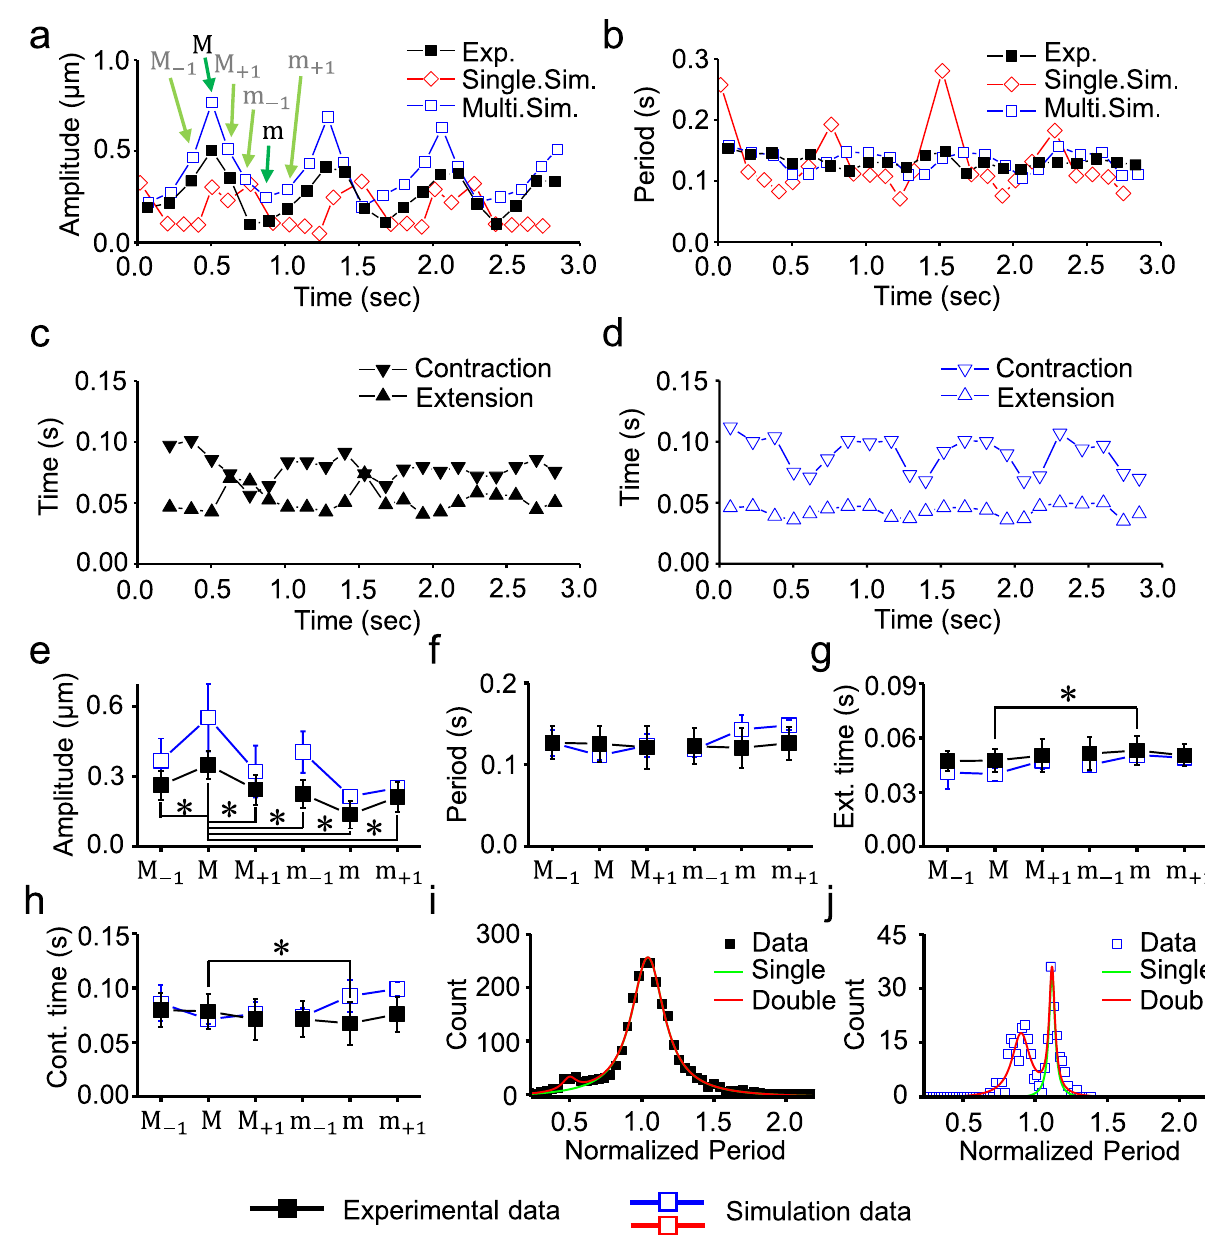
Figure 2. Statistical analysis results for the oscillation characteristics of HSOs. (a,b) Changes in the amplitude ( a ) and period ( b ) of the oscillation waveform in Fig. 1f. ( c,d) Changes in contraction (inverted triangles) and extension time (triangles) for the oscillation waveform in Fig. 1f. The experimental data ( c ) and simulation data ( d ) are shown for the contraction and extension times. ( e–h) The oscillation cycles where the amplitude reached the maximum (“M-cycle”) and minimum (“m-cycle”) and the cycles before and after the M- and m-cycles were analyzed. ( e ), oscillation amplitude; ( f ), oscillation period; ( g ), extension time; ( h ), contraction time. Significant differences between groups are indicated with an asterisk (*). All pairs of maximum amplitudes and other amplitudes in ( e ) had significant differences. (i,j) Histograms of the oscillation periods normalized by the mean periods for the ( i ) experimental data and ( f ) simulation data. The data were fitted to double Lorentz distributions ( i ; R = 0.996 , j ; R = 0.940). Closed symbols, experimental data; open blue symbols, simulation data ( a–j ). The green arrows show specific examples of the labels ( e–h ) for the open blue symbols ( a ). The open red symbols indicate the single-half-sarcomere model simulation data ( a,b ). Black lines, experimental data; blue lines, simulation